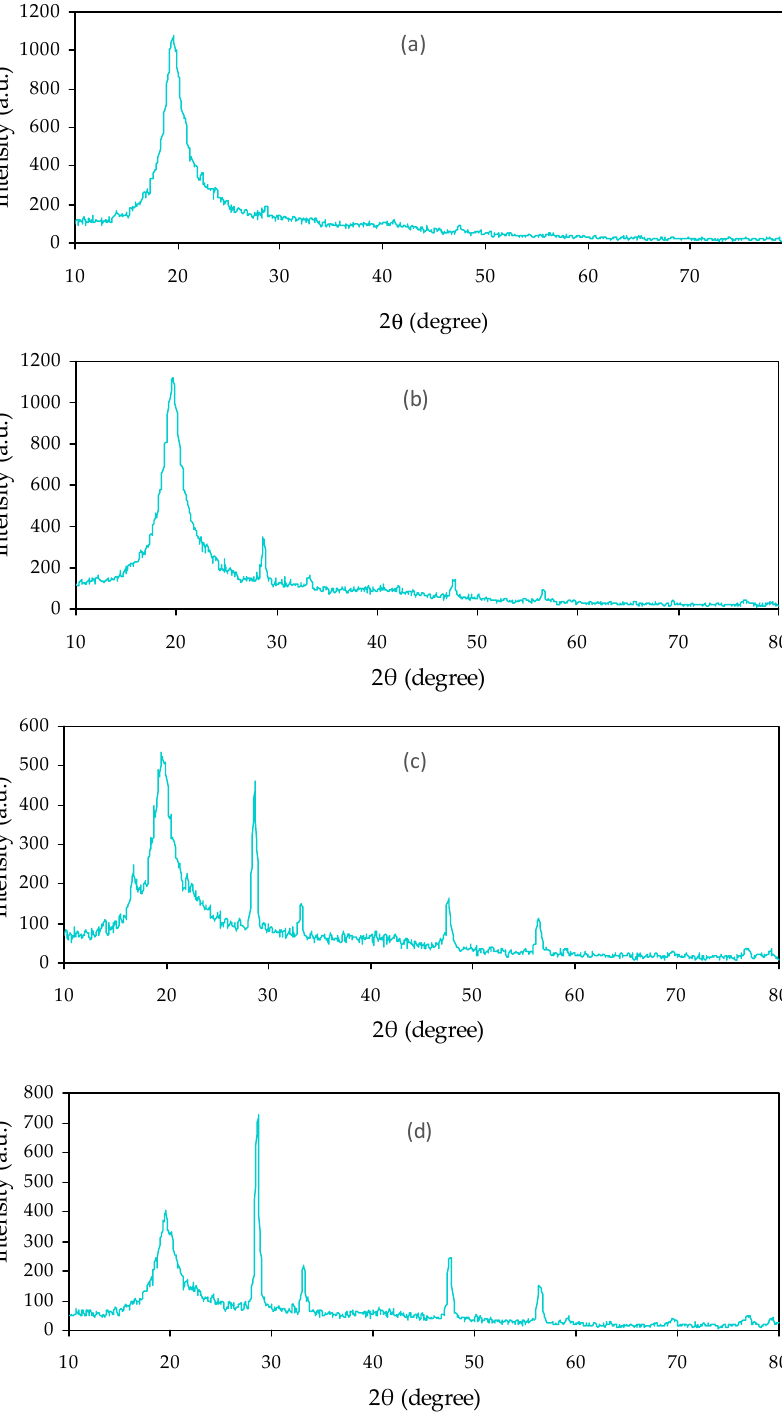
Figure 4. XRD pattern of ( a ) SPNC-1, ( b ) SPNC-2, ( c ) SPNC-3, and ( d ) SPNC-4 Figure 2. XRD pattern of ( a ) SPNC-1, ( b ) SPNC-2, ( c ) SPNC-3, and ( d ) SPNC-4 samples.